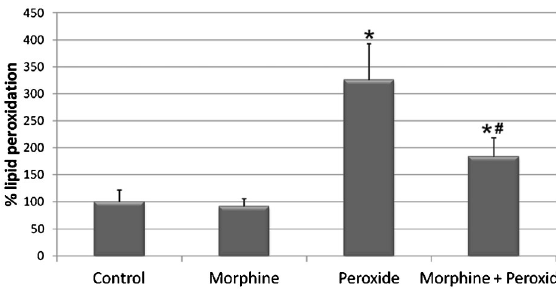
Figure 2. Lipid peroxidation of C6 cell line exposed to 0.0025% hydrogen peroxide (H 2 O 2 ) and/or 1 m M morphine for 24 h. Data are reported as means±SE. *P , 0.05 vs control and morphine groups; # P , 0.05 vs peroxide group (ANOVA and Tukey test).